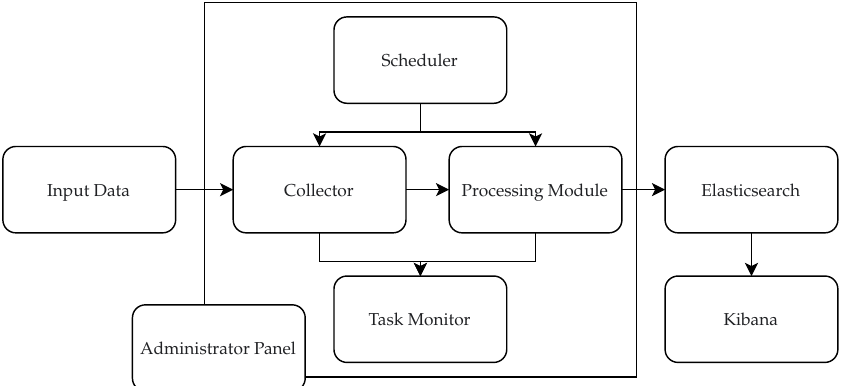
Figure 3. Simplified architecture of the newly developed VMC